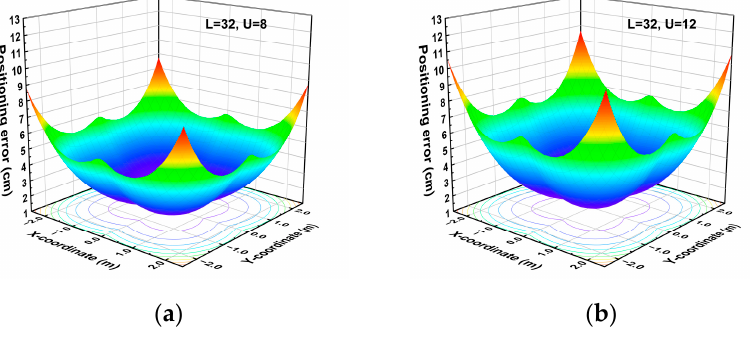
Figure 5. Surface diagram of positioning error estimated at all testing points when the user number is ( a ) 8 users, ( b ) 12 users, and ( c ) 16 users.